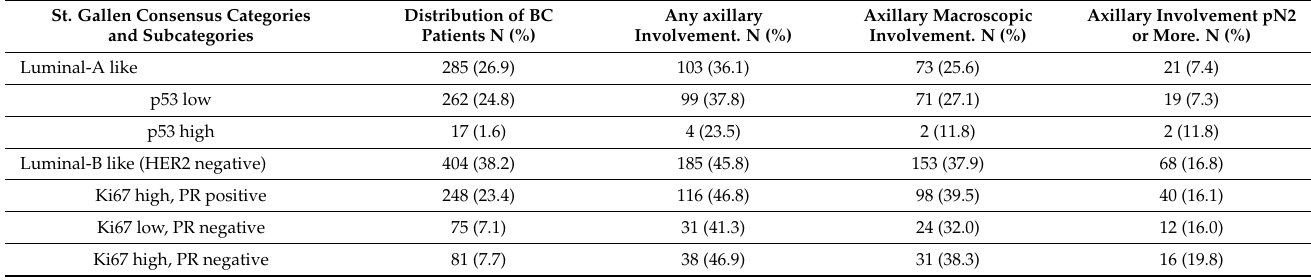
Table 2. Correlation between categories, subcategories and axillary